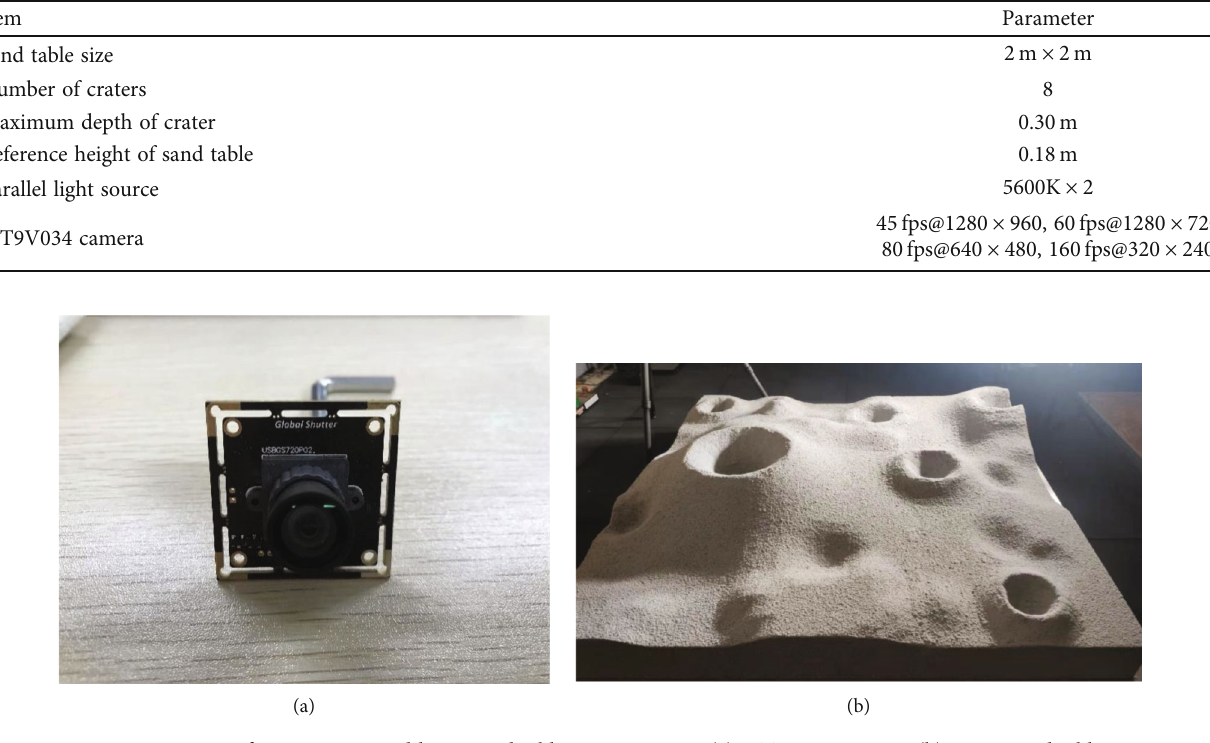
Figure 8: Front-facing camera and lunar sand table in experiment. (a) MT9V034 camera. (b) Lunar sand table.